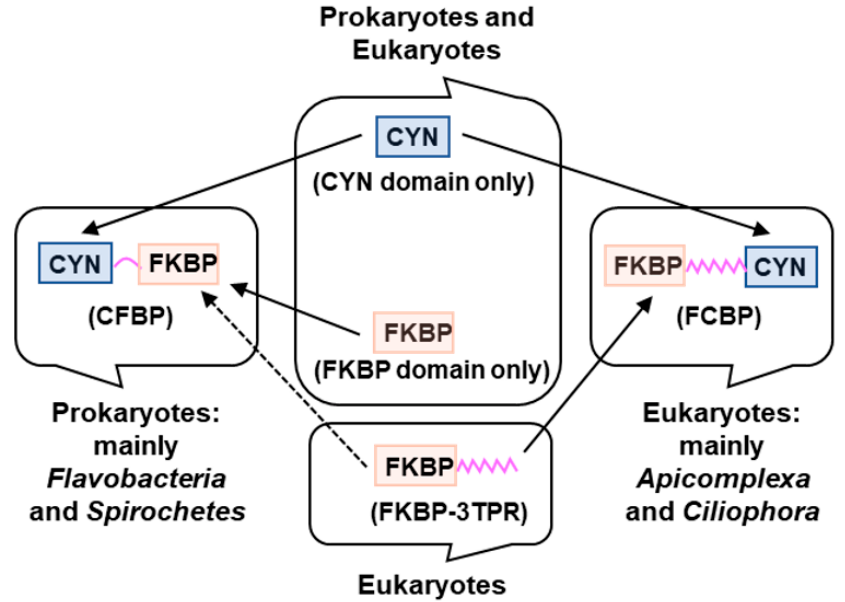
Figure 1. Proposed biogenesis of the two types of dual-family PPIases (DFPPIs), detailed in the text. CYN: cyclophilin; FKBP: FK506-binding protein; TPR: tetratricopeptide repeat. The known occurrences of the domains, namely CYN (cyan), FKBP (salmon), TPR (pink), in the various organisms are indicated. The same color code has been used in all Figures of this review. Of note, all DFPPI-containing organisms, found so far, are monocellular.